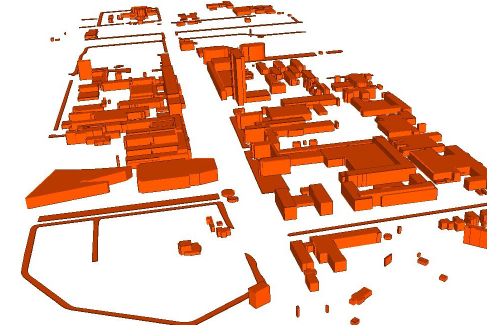
Figure 5: TU Delft campus objects. Only the buildings have been selected.